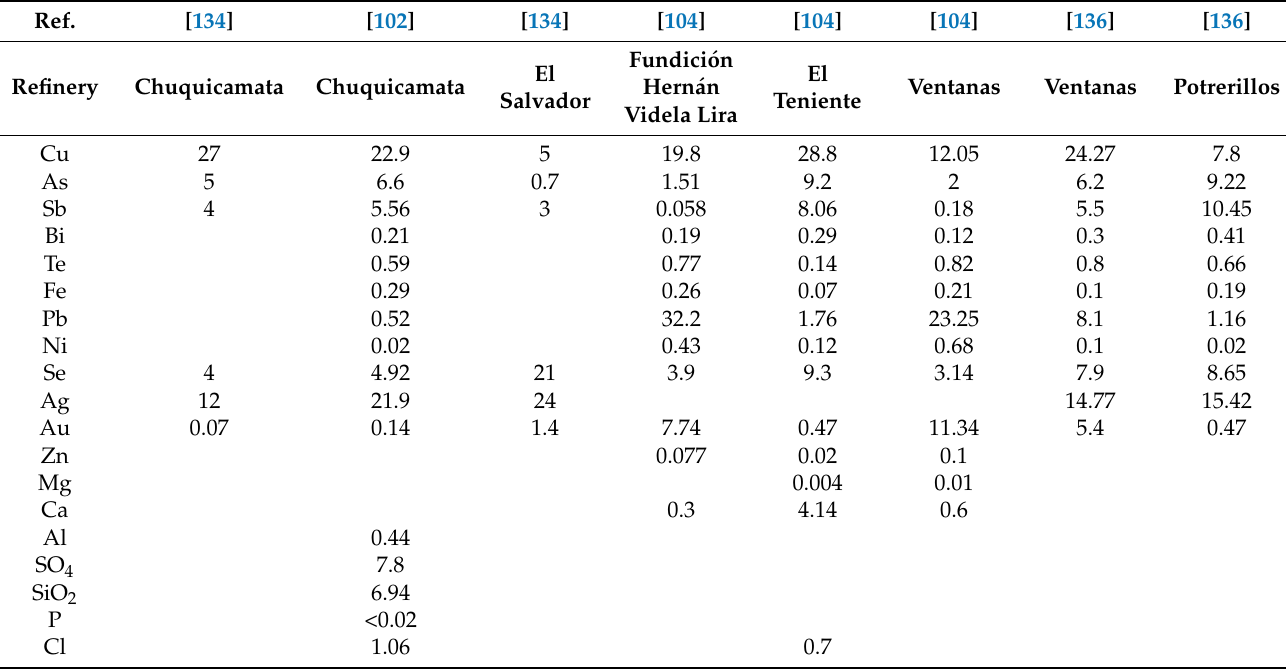
Table 10. Composition (wt%) of Chilean anode